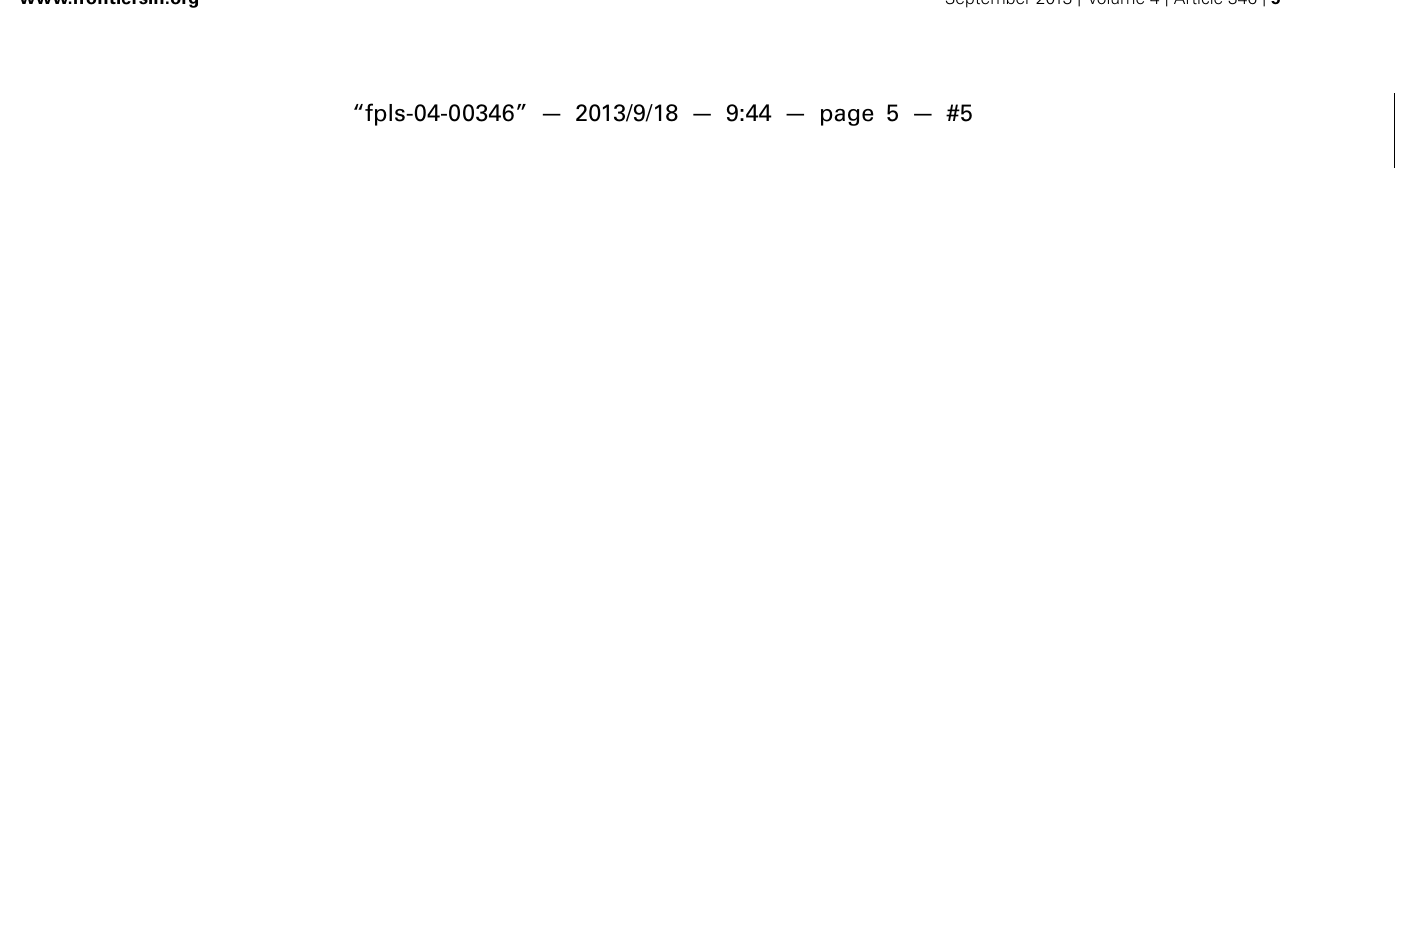
up-regulate ABA catabolism through NO, and also GA biosynthesis. A high concentration of ABA also inhibits GA biosynthesis, but a balance of these two hormones jointly controls seed dormancy and